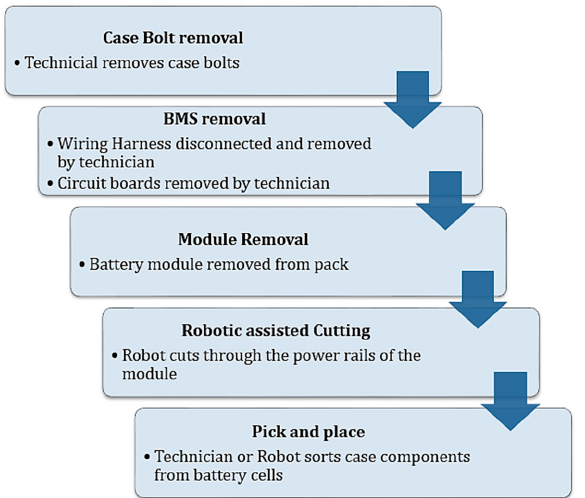
Figure 2. Process workflow as modified for a technician–robot collaboration.